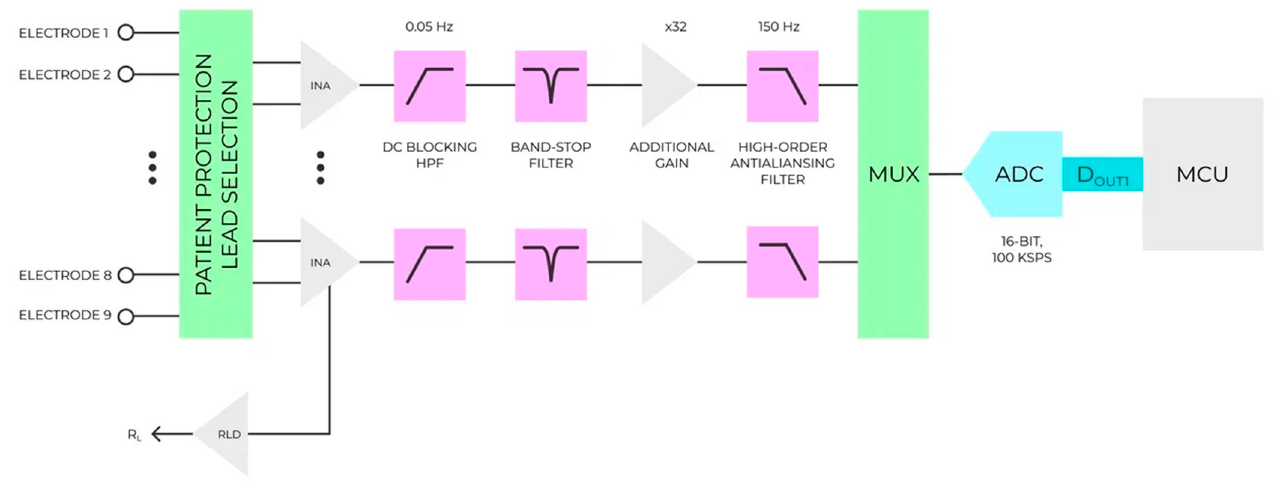
Figure 10. Structure of a standard SAR-based bioamplifier circuit.